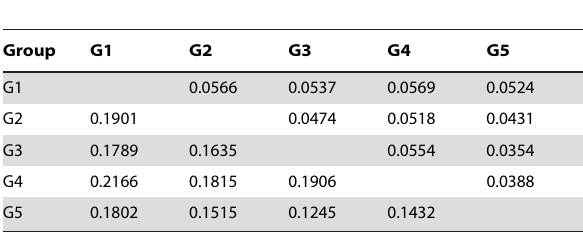
Table 3. Genetic distance between M. sinensis